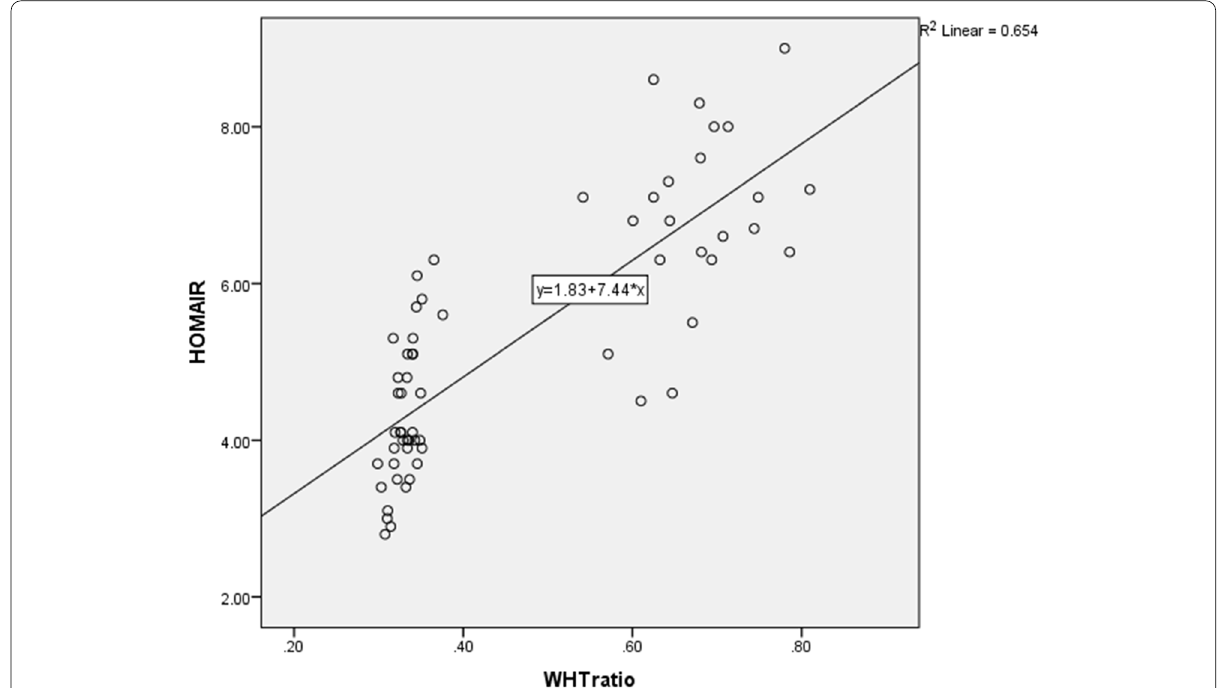
Fig. 1 Linear regression analysis between WHtR and HOMA-IR. R 2